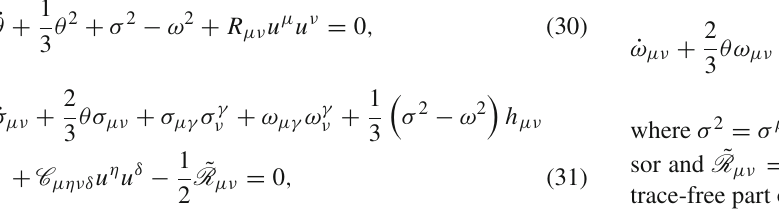
˙ θ + 1 θ 2 + σ 2 − ω 2 + R μν u μ u ν = 0 3